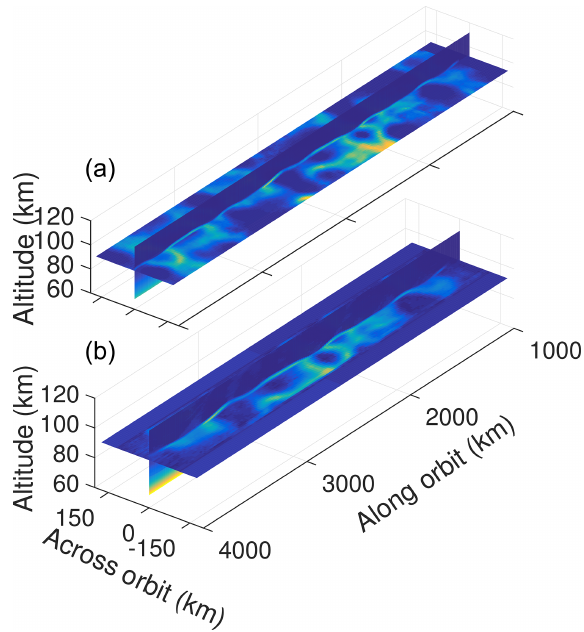
Figure 8. Example of tomographic retrieval simulations. Panel (a) shows the simulated “true” NLC volume scattering coefficient. Panel (b) shows the retrieved NLCs. Based on the simulated lines of sight, full retrieval is available in an area 2000–3000km along orbit and ± 125km across